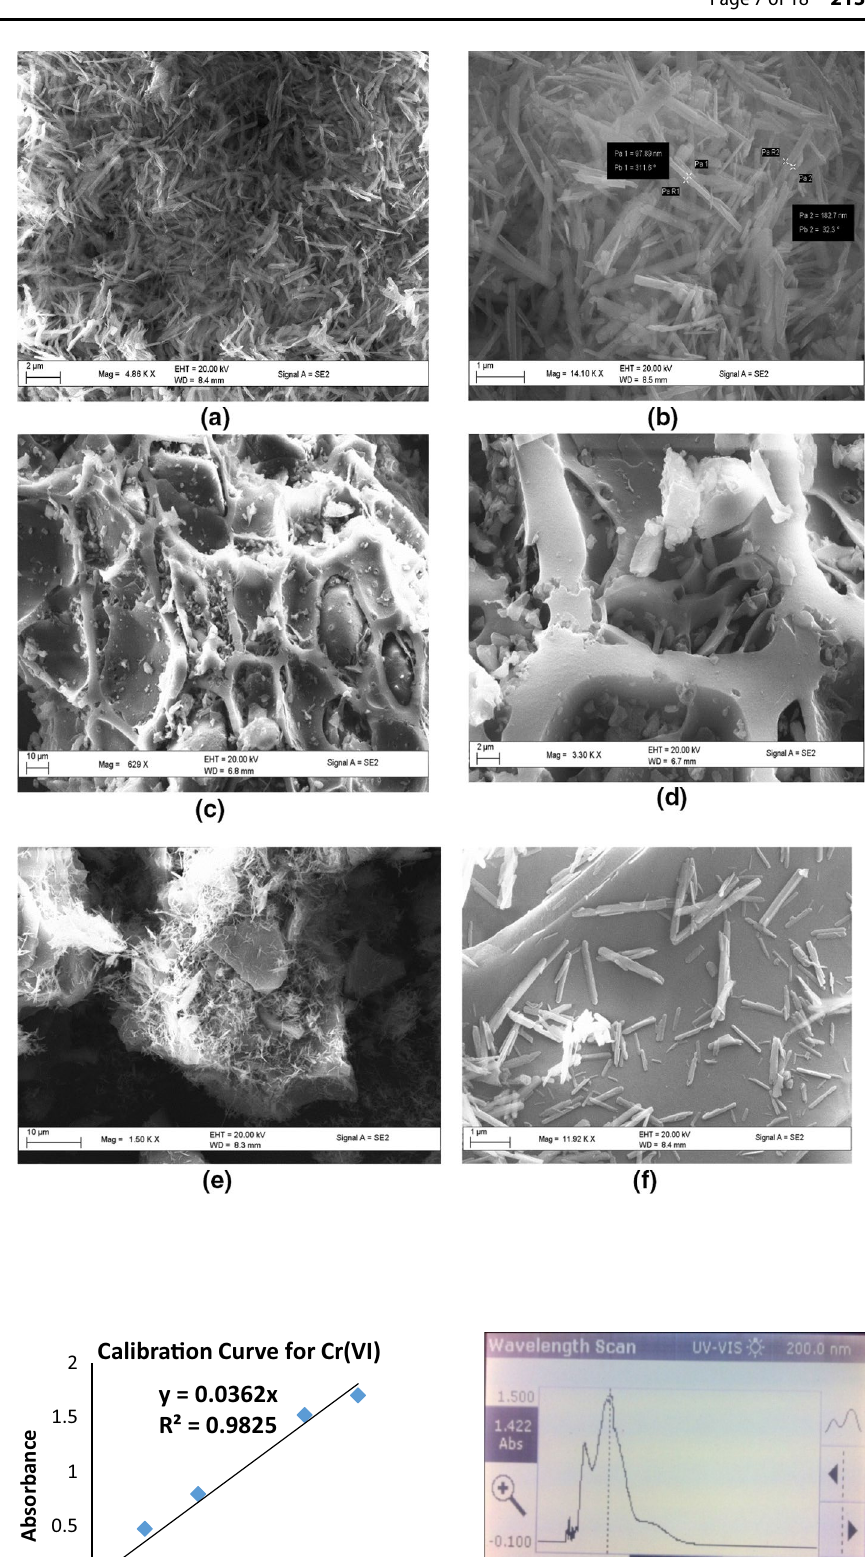
Fig. 2 a G at magnification of 4.86 kX, b G at magnification of 14.10 kX, c AC at magnifica-